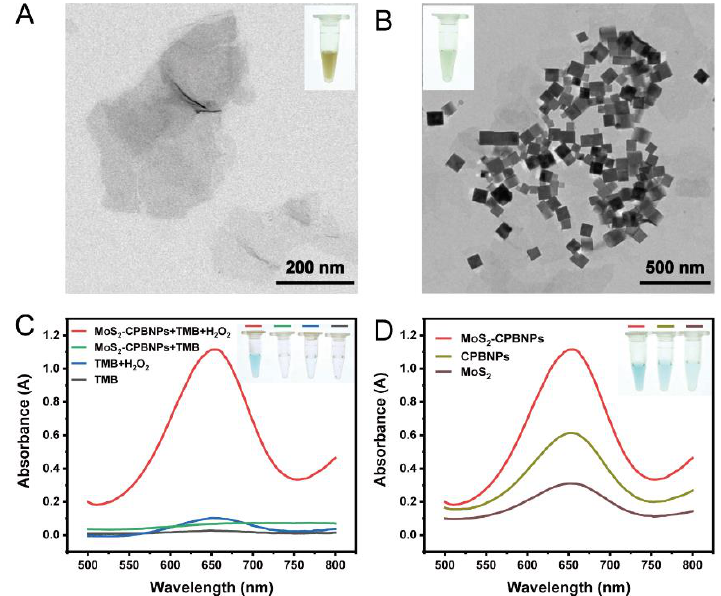
Figure 1. TEM images of ( A ) MoS 2 and ( B ) MoS 2 -CPBNPs. ( C ) Visible absorption spectra of solutions containing TMB, TMB + H 2 O 2 , MoS 2 -CPBNPs + TMB and MoS 2 -CPBNPs + TMB + H 2 O 2 . ( D ) Catalytic behavior of MoS 2 , CPBNPs and MoS 2 -CPBNPs towards the oxidation of TMB.